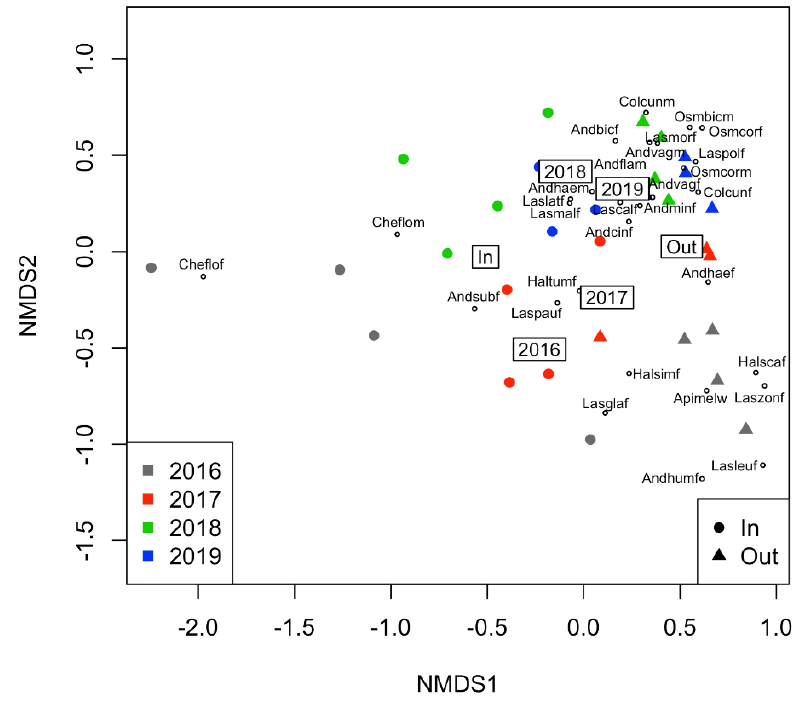
Figure 4. Ordination plot with non-metric multidimensional scaling (NMDS) of bees collected in coloured pan traps placed inside (circles) and outside (triangles) the netted plot of apple trees during the flowering period in the years 2016–2019 (different colours). Each data point represents the seasonal sum of one trapping station. Species with less than 5 collected individuals over all years and traps were not considered. For abbreviations of species names see Supplementary Materials, Table S3. The centroids of each year and the plot type (in/out) are indicated in boxes.